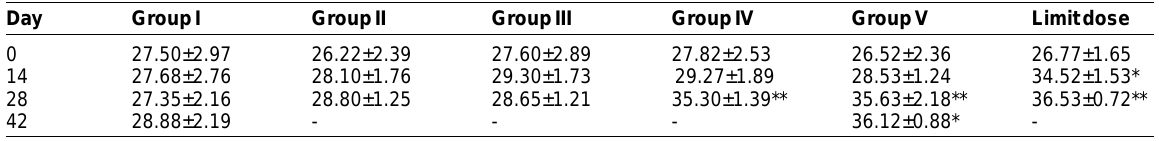
Table-1. Levels of alanine aminotransferase ALT (U/L) in rats fed with S. laurifolius leaf extract in repeated dose 28 day oral toxicity study